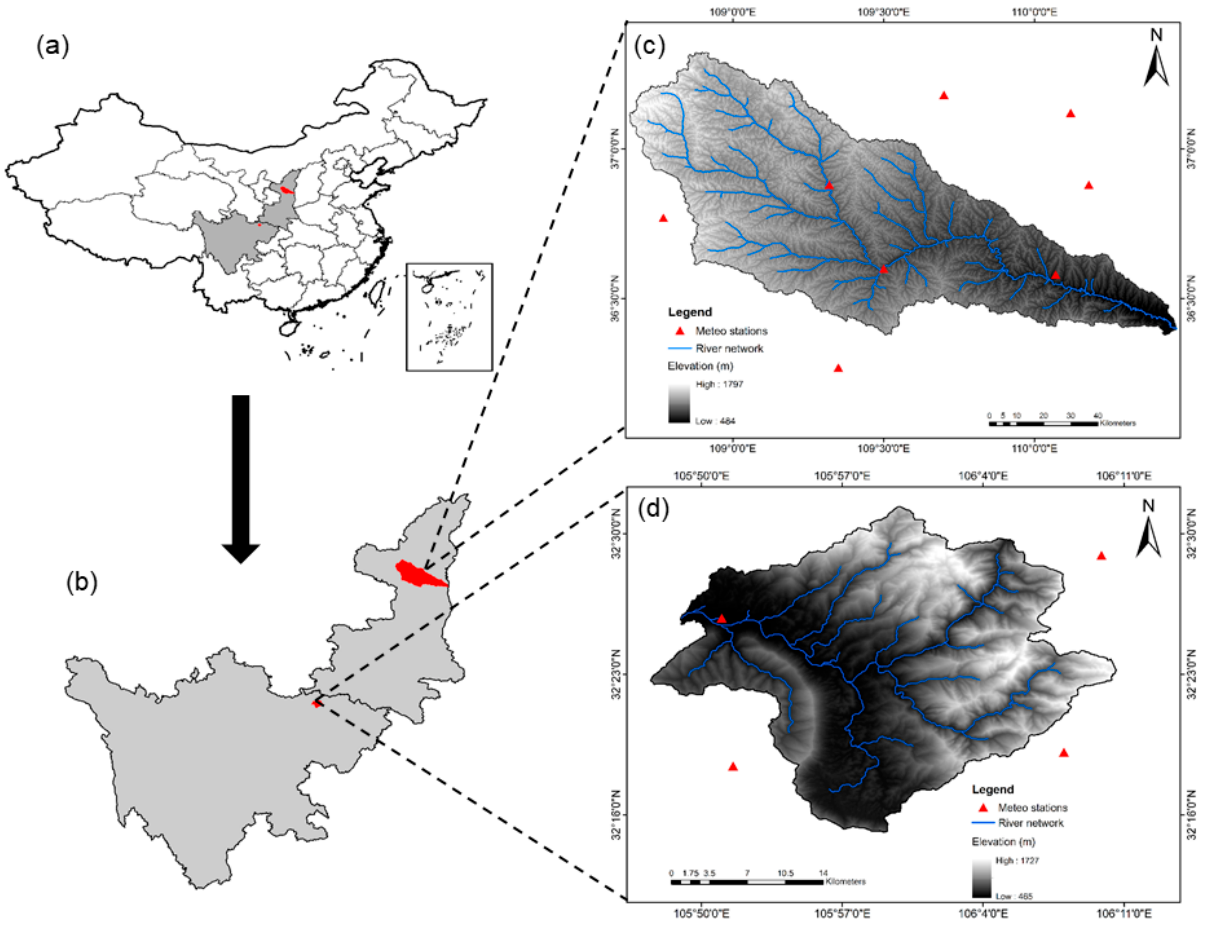
Figure 1. The location of the two study catchments used in this study in China ( a ), location of study area catchments in Shaanxi and Sichuan provinces ( b ), respectively, the Yanhe ( c ) and Guangyuan ( d ) study area boundary; elevation with the stream network is shown with blue solid lines and red triangles represent meteorological stations.